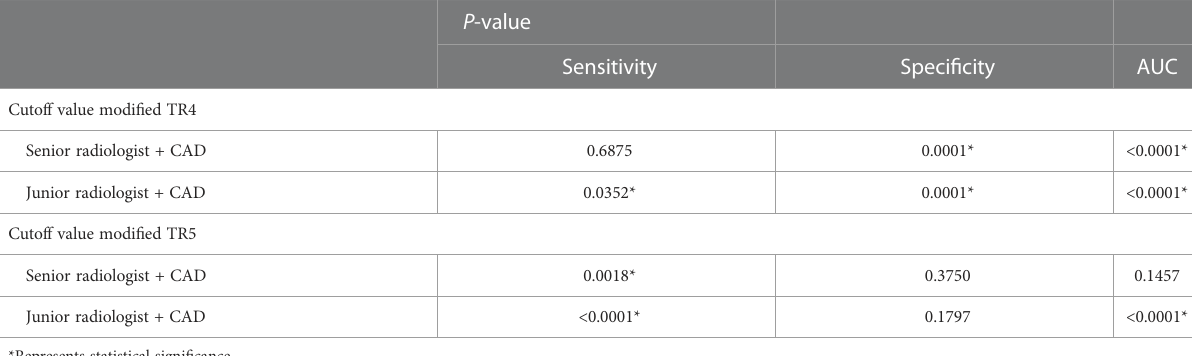
TABLE 6 Quantitative indicators of the two radiologists combined with the CAD system compared with the radiologists alone.